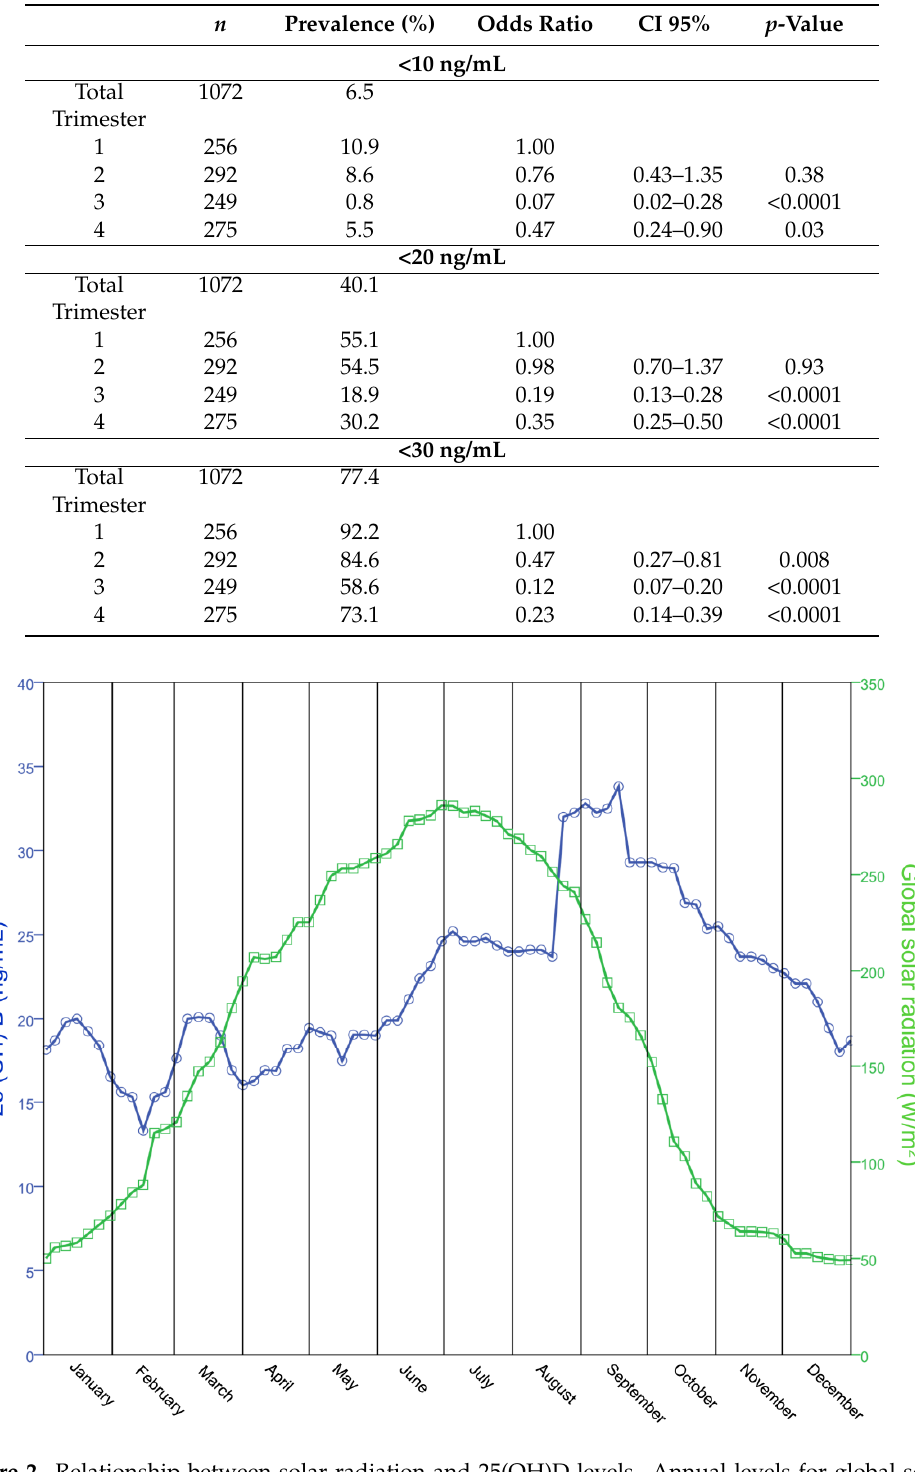
Table 2. Prevalence of serum 25(OH)D concentration below the threshold values of 10 ng/mL, 20 ng/mL and 30 ng/mL and according to the four trimesters. The first trimester was used as a reference group for odds ratio calculation. CI, confidence interval.